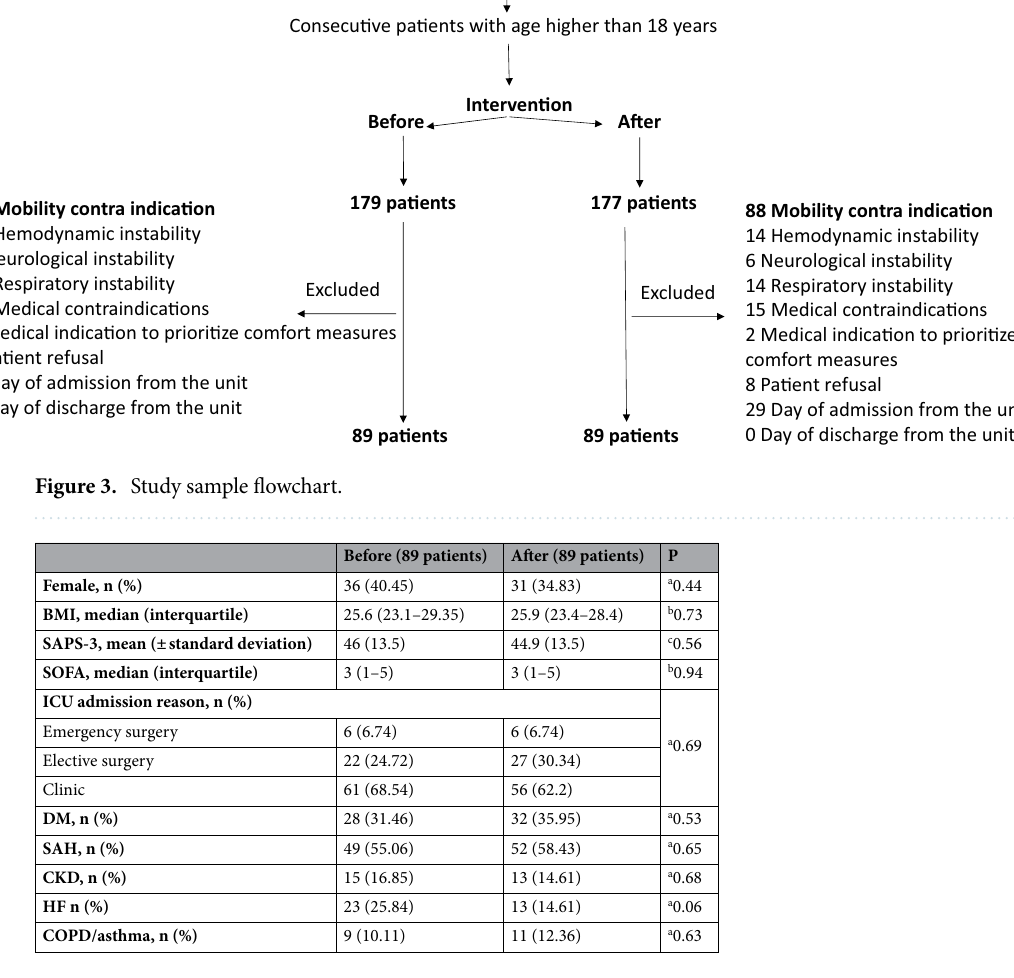
Table 1. Baseline characteristics. BMI body mass index, SAPS 3 Simplified Acute Physiology Score, SOFA Sequential Organ Failure Assessment, ICU intensive care unit, DM diabetes mellitus, SAH systemic arterial